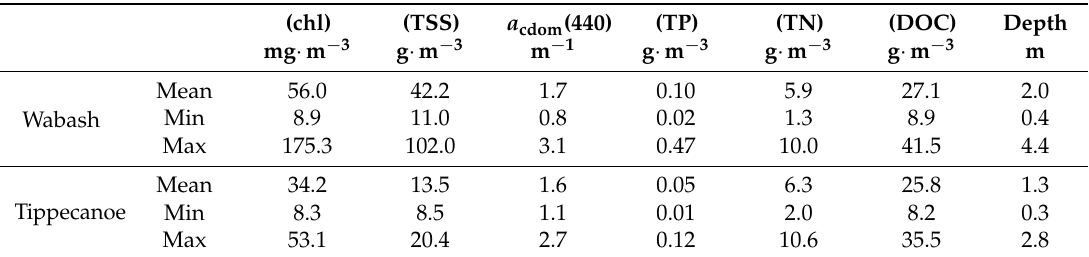
Table 1. Summary of water quality observations of the Wabash River and the Tippecanoe River in summer